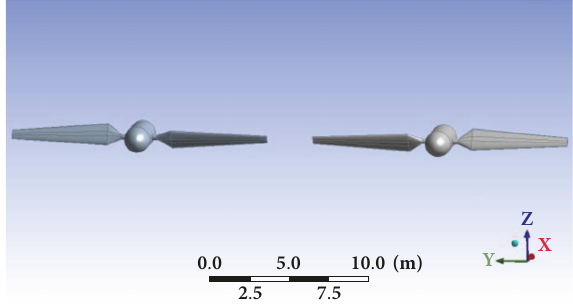
Figure 3: 3-D turbine